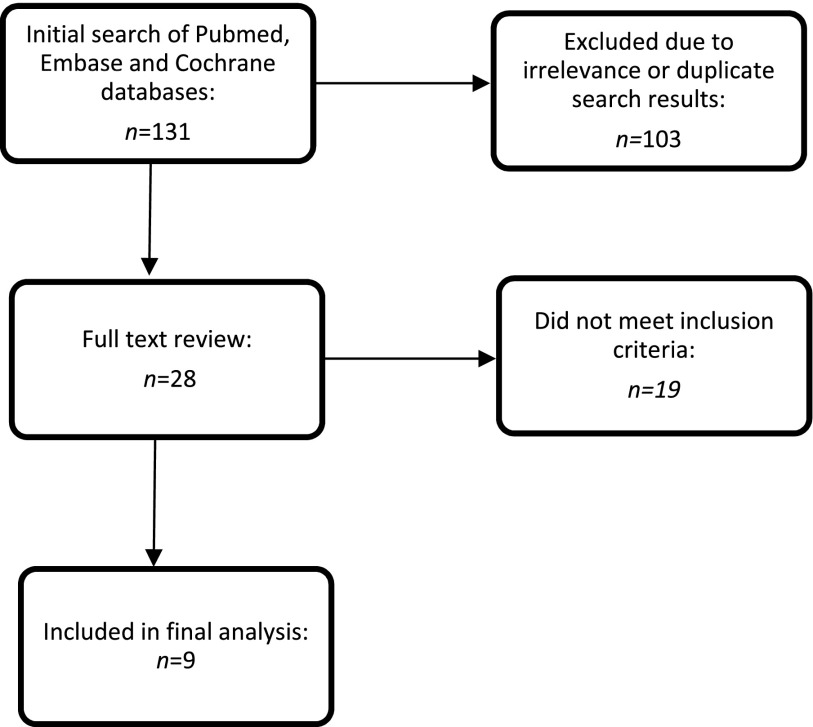
Search strategy.